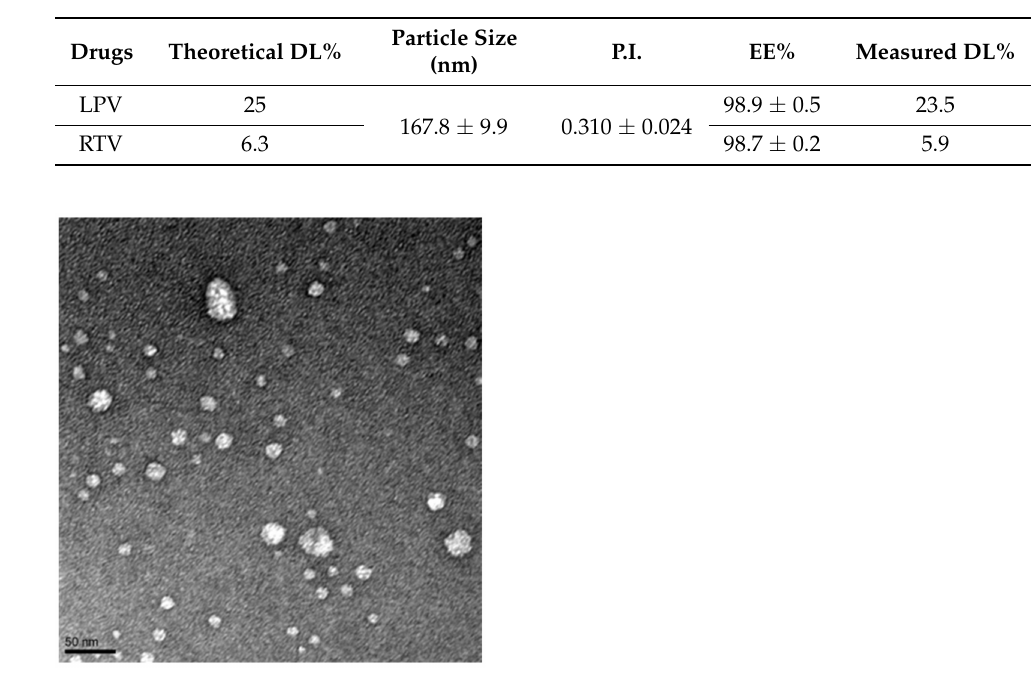
Table 1. Physicochemical properties of LPV/RTV ISNPs. Data are presented as the mean ± SD ( n = 3).